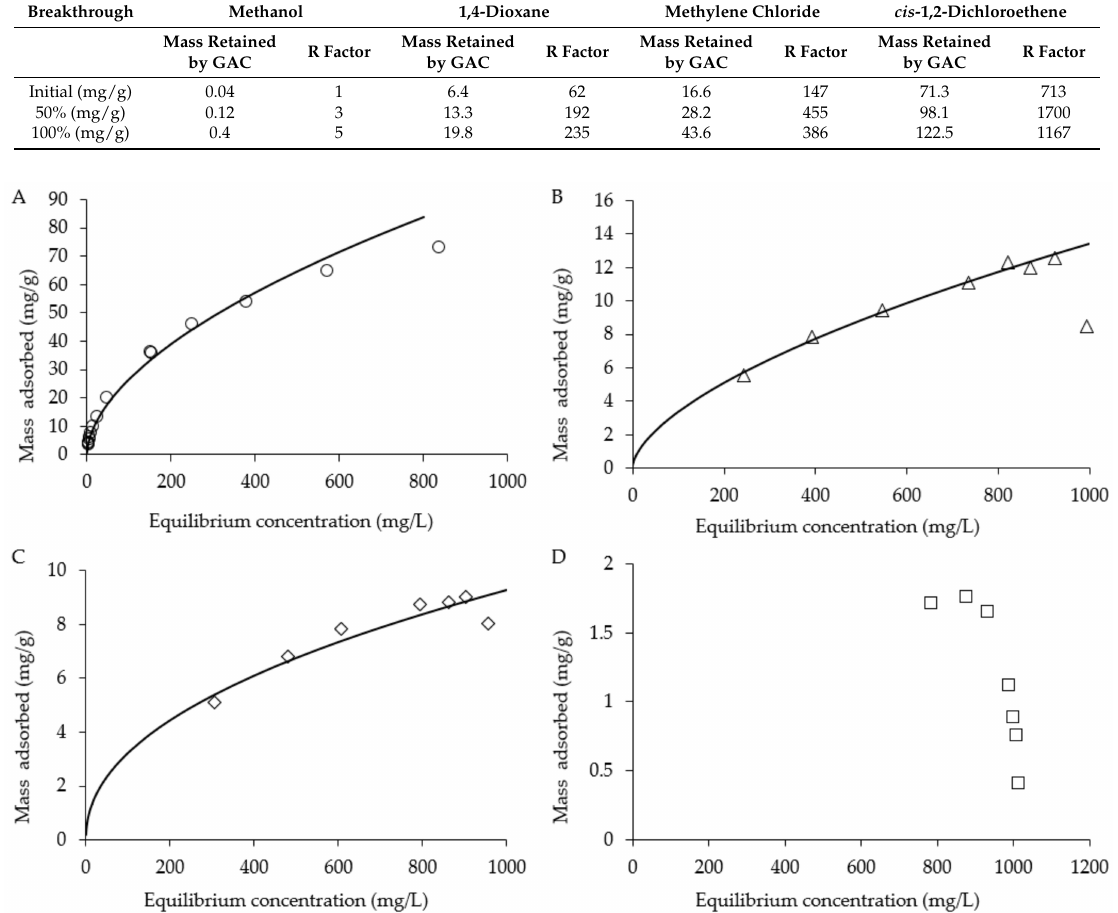
Figure 3. Breakthrough curves for ( A ) methanol, ( B ) 1,4-dioxane, ( C ) methylene chloride and ( D ) cis - dichloroethene for the 1-D multispecies column